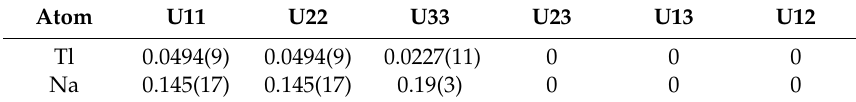
Table 4. Anisotropic displacement in Å 2 parameters of the atoms in tetragonal sodium thallide.